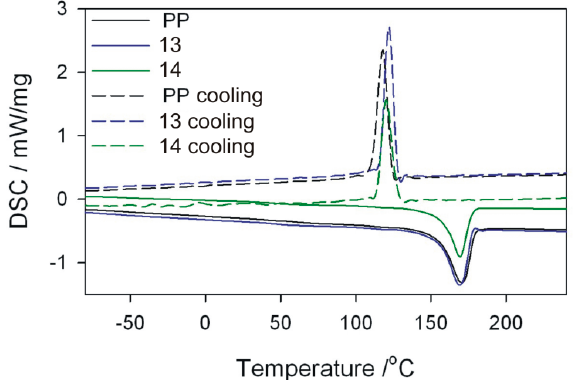
Figure 17. DSC curves for PP sample and extrudate samples–layouts 13 and 14. Sample designations as in Table 1.